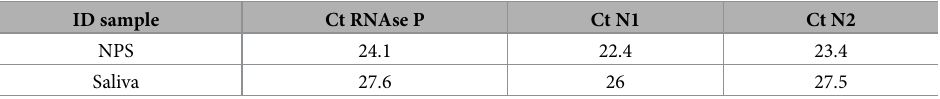
Table 3. Comparison of RNAse P, N1 and N2 Cts in a positive patient with SARS-CoV2, using paired samples (NPS and saliva). ID sample